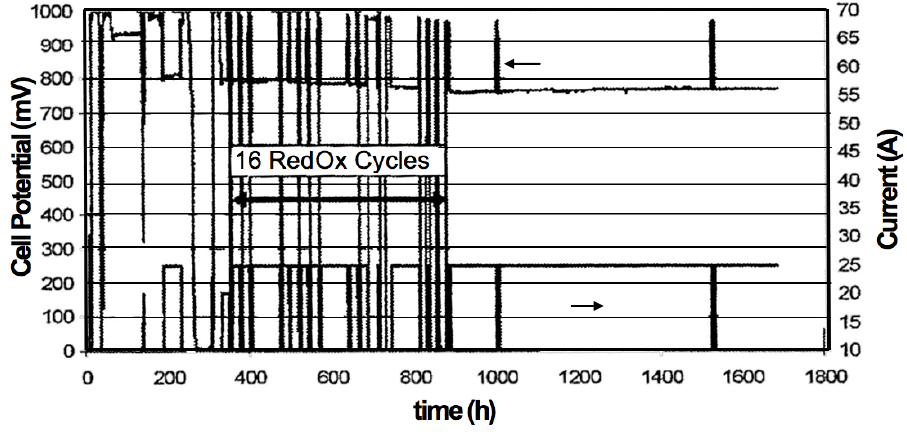
Figure 32. Anode supported cell tested over 16 RedOx cycles and 1700 h on a single repeat unit stack configuration. Test conditions: 800 °C, active surface area about 100 cm 2 and constant current load of 0.25 A/cm 2